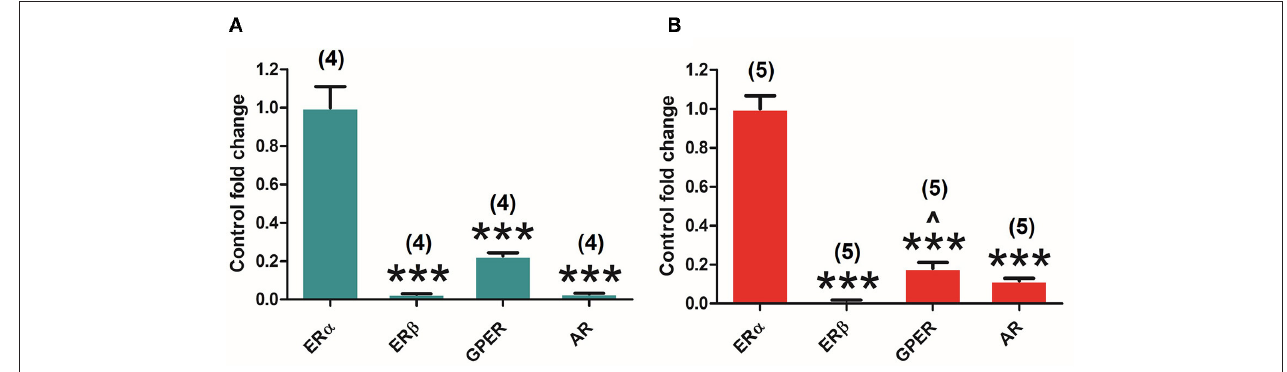
FIGURE 2 | Differential estrogen receptor (ER) and androgen receptor (AR) expression in the pituitary gland of adult male and female rats. (A) ER α , ER β , G protein-coupled estrogen receptor (GPER), and AR expression in male animals ( n = 4). (B) ER α , ER β , GPER, and AR expression in female animals ( n = 5). Data are represented as mean ± SEM. ***Significant differences (*** p < 0.001) vs. ER α values. ∧ Significant differences ( ∧ p < 0.05) vs. ER β values.